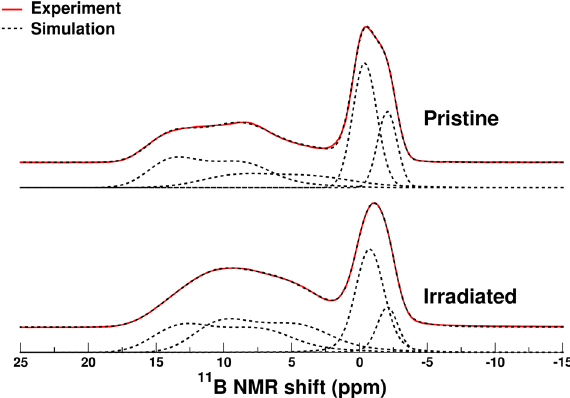
Fig. 3 NMR MAS spectra of 11B in the no- irradiated and pre- irradiated CJ2